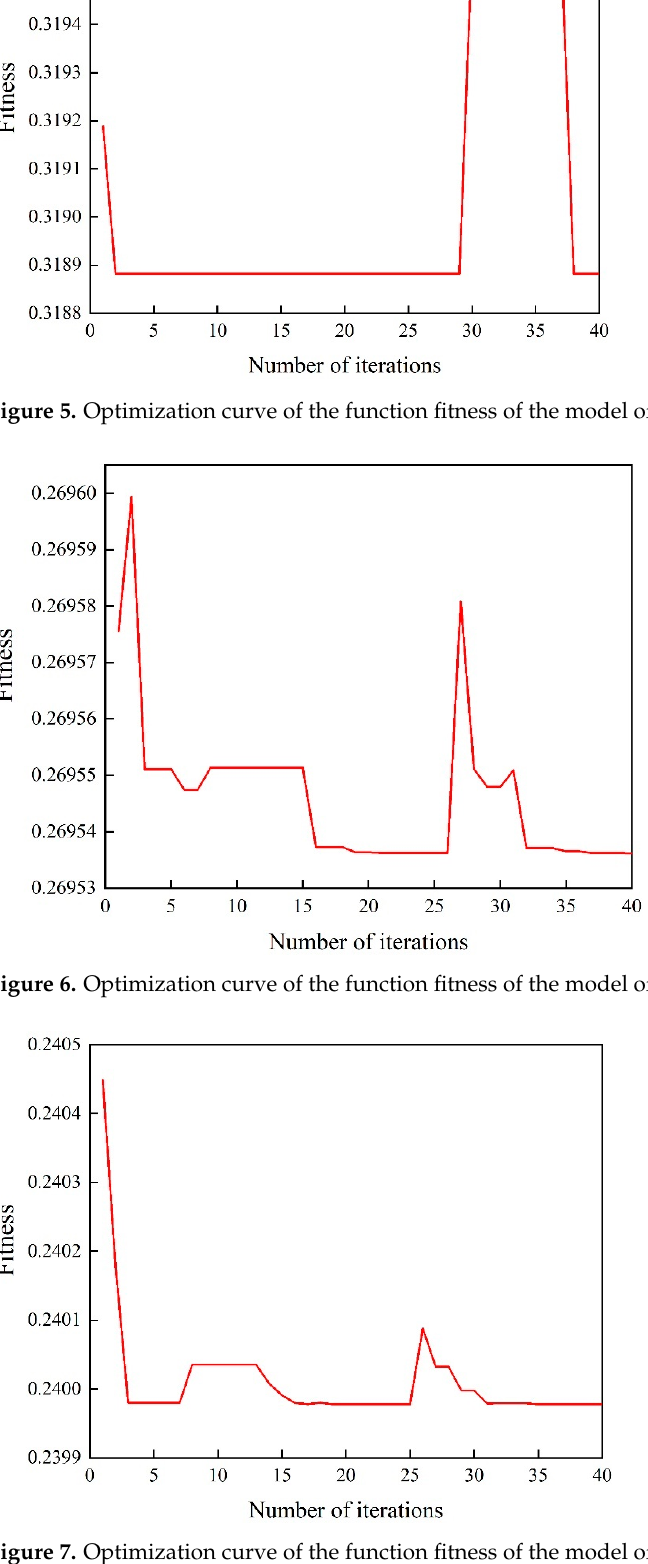
Table 4. Optimization results.